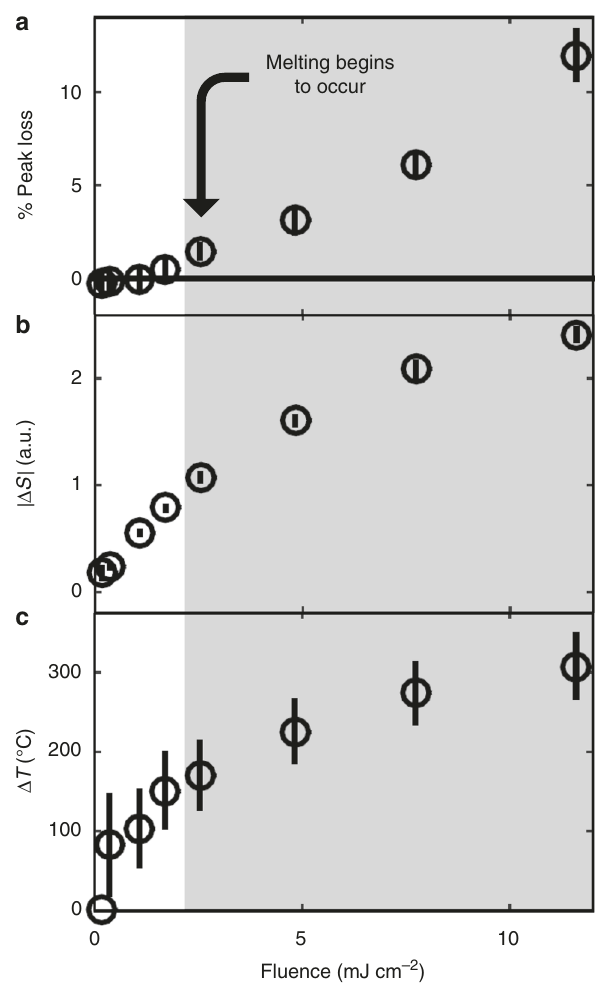
Fig. 5 Fluence-dependent lattice temperature and onset of NC melting. a Reversible percent loss of peak intensity 40 ps following photoexcitation versus excitation fl uence. Error bars indicate standard deviation in the measurement. The gray box indicates fl uences past the melting threshold. b Integrated absolute change in scattering signal versus excitation fl uence. Error bars indicate standard deviation in the measurement. c Change in NC temperature versus excitation fl uence. Error bars indicate 95% con fi